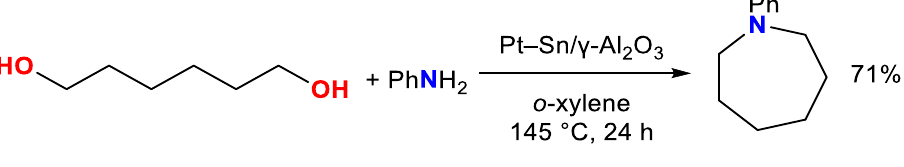
Table 5. Typical catalysts used for diol cyclization.